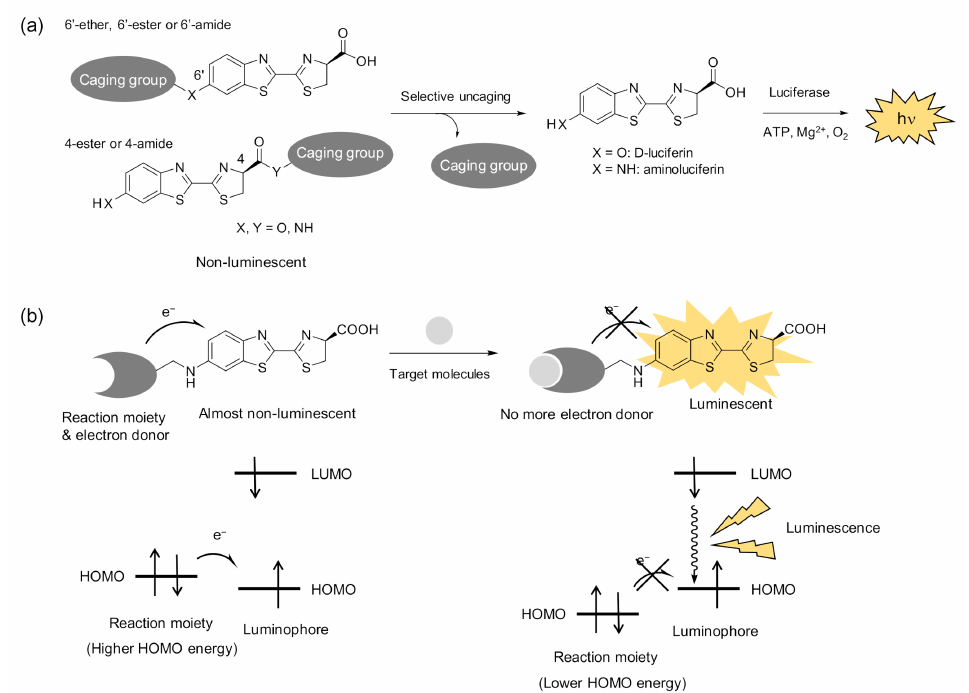
Figure 5. Molecular designs for the development of bioluminescence probes. The design strategy of ( a ) caged luciferin and ( b ) bioluminescent-enzyme induced electron transfer (BioLeT). The rate of electron transfer is strongly dependent on the highest occupied molecular orbital (HOMO) energy level of the electron donor. If the HOMO energy level of the electron donor is enough high, after luciferin derivatives react with luciferase, the electron transfer easily occurs from the electron donor to the excited luminophore. In this case, the excited electron cannot return to the HOMO of the luminophore, resulting in loss of bioluminescence. When the HOMO energy level of the electron donor becomes lower after reaction with target molecules, the electron transfer does not occur anymore, and bioluminescence should be